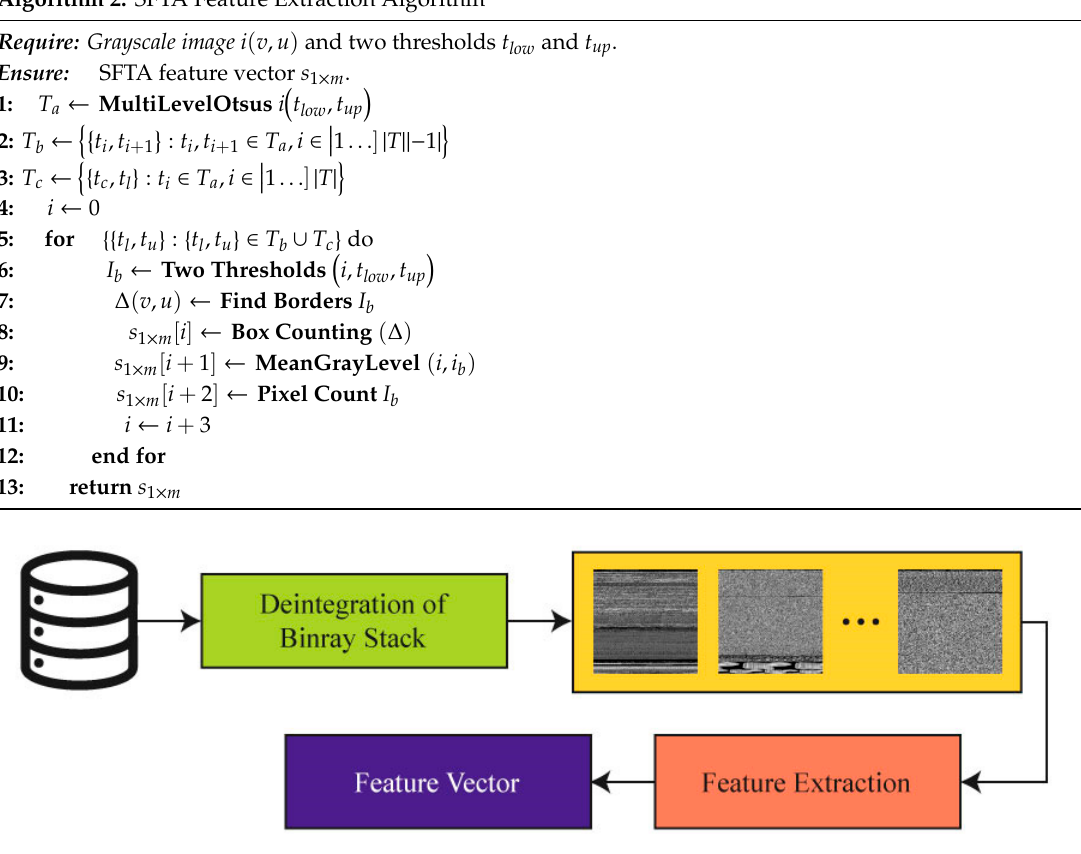
Algorithm 2. SFTA Feature Extraction Algorithm